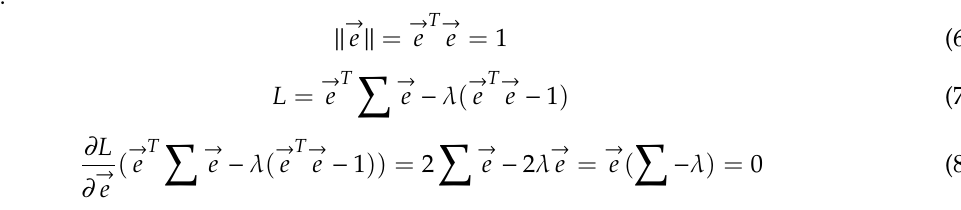
Figure 8. Scatter diagram and result of data projection on principal component vector.